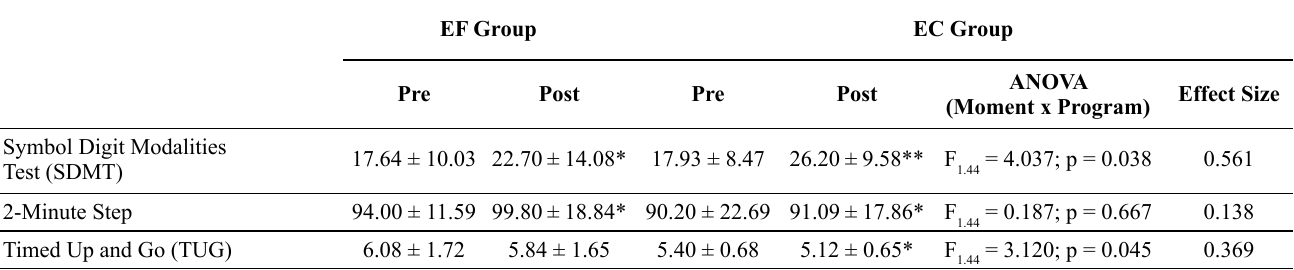
Table 2. Effects of the programmes implemented on cognitive functions, aerobic capacity and dynamic balance (Univariate